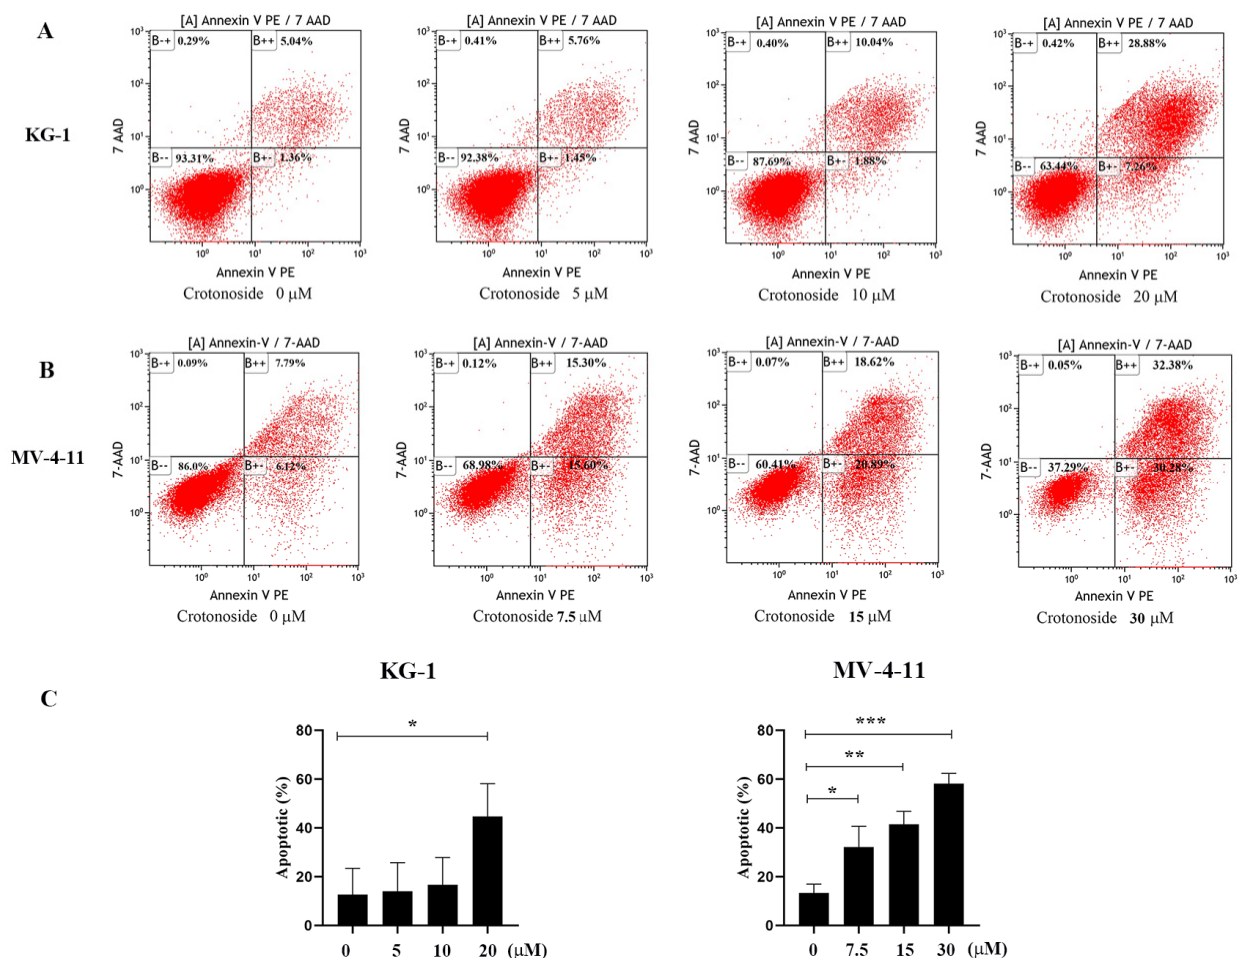
Figure 10. Effects of different concentrations of crotonoside on AML cell apoptosis: ( A ) KG-1 cells and ( B ) MV-4-11 cells were exposed to crotonoside at different concentrations for 48 h, and 0.1% DMSO (0 μ M) as control, then cells were harvested and stained with annexin V-PE/7-AAD for flow cytometry analysis Dual staining for annexin V-PE and 7-ADD permitted the discrimination among live cells (B − − ), early apoptotic cells (B + − ), late apoptotic cells (B + +), and necrotic cells (B − +); ( C ) Statistical summary of apoptosis based on flow cytometry dot plots graphs, * p < 0.05, ** p < 0.01, *** p < 0.001 vs. 0 μ M. All the data are presented as means ± SD from three independent experiments.